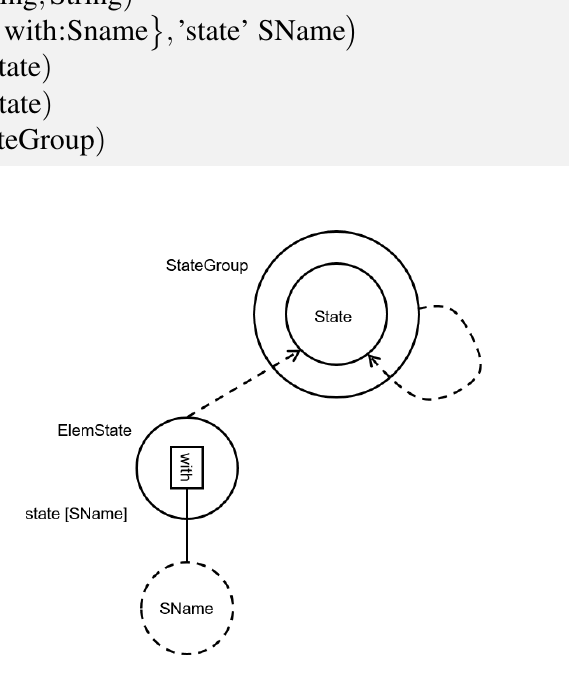
Figure 12. State Decomposition